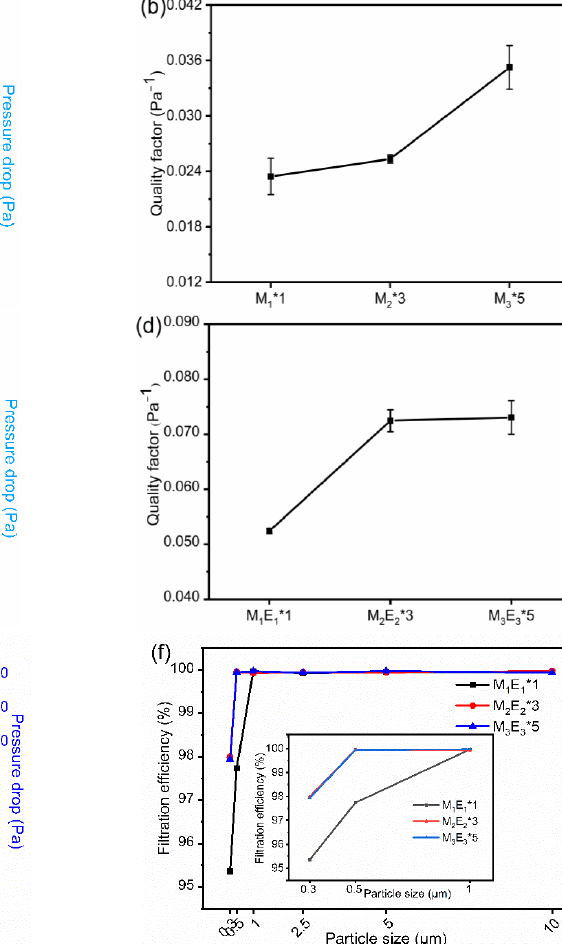
Figure 7. Meltblown filters ( a ) filtration efficiency, pressure drop, and ( b ) quality factor. Laminated micro/nano filters ( c ) filtration efficiency, pressure drop, and ( d ) quality factor. s. ( e ) Filtration efficiency and pressure drop of M 3 E 3 *5 with different flow rates. ( f ) Filtration efficiency versus the particle size. The detection particle size is 0.3 µm in ( a , c , e ).